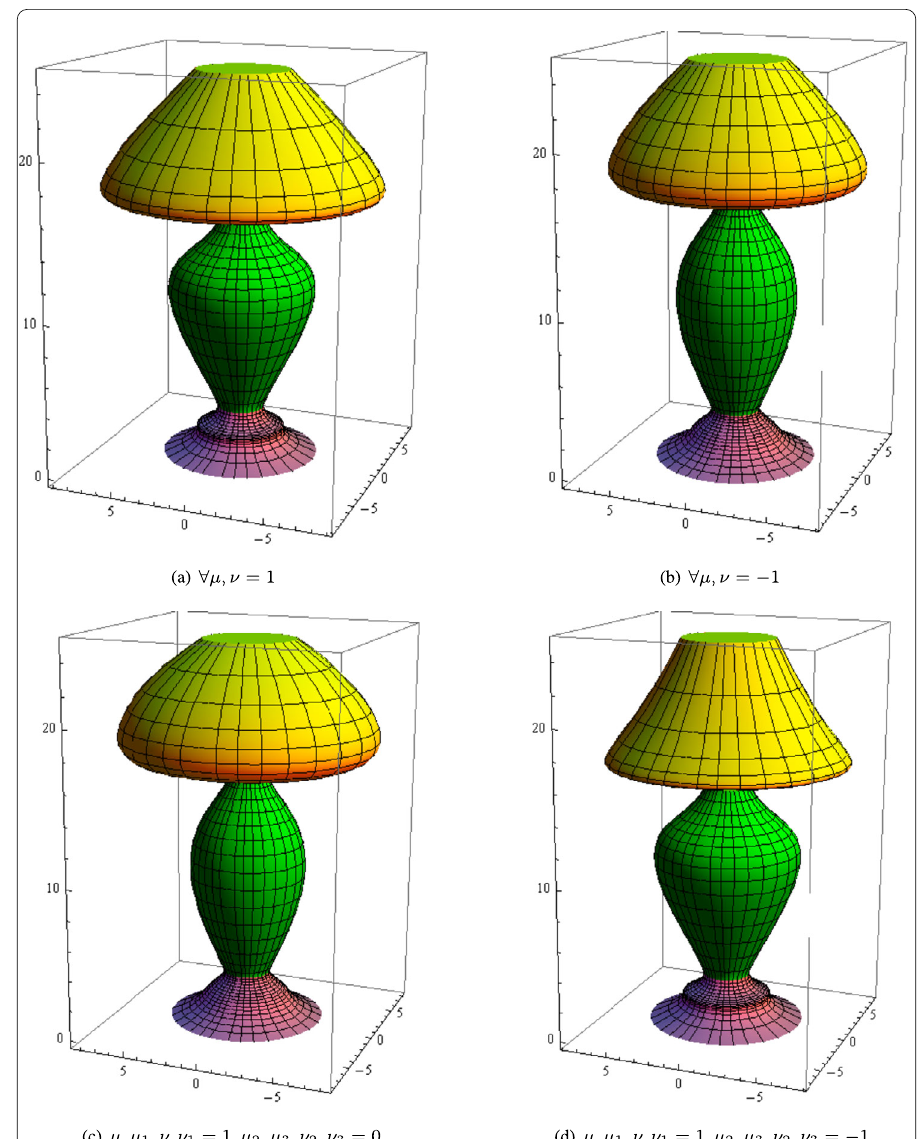
Figure 26 Design example of a lamp with different shape